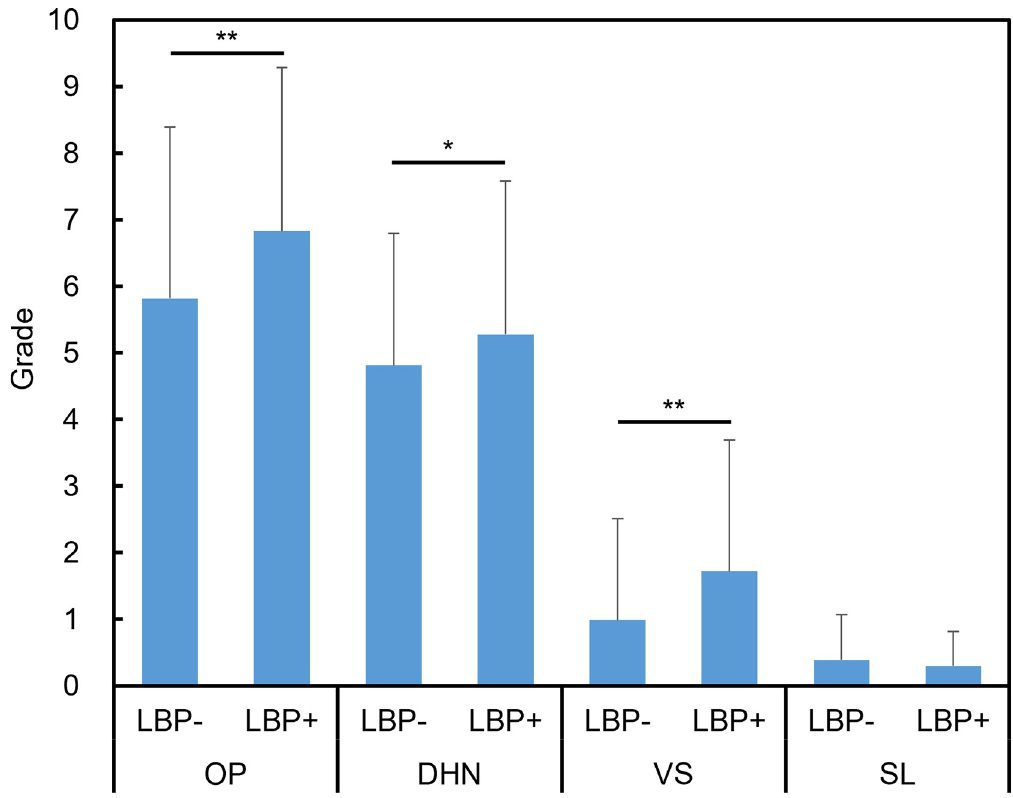
Fig 4. Radiographic features of whole lumbar with or without low back pain. Mean wOP (sum of grades of osteophytes from L1/L2 to L5/S1) ( A ), wDHN (sum of grades of disc height narrowing from L1/L2 to L5/S1) ( B ), wVS (sum of grades of vertebral sclerosis from L1/L2 to L5/S1) ( C ), and wSL (sum of grades of spondylolisthesis from L1/L2 to L5/S1) ( D ) with low back pain (LBP+) or without LBP (LBP-) at each intervertebral level are shown. Grades in each radiographic feature between the two groups were compared using the Mann-Whitney test. Data are expressed as mean ± standard deviation. � P < 0.05 and �� P < 0.01.